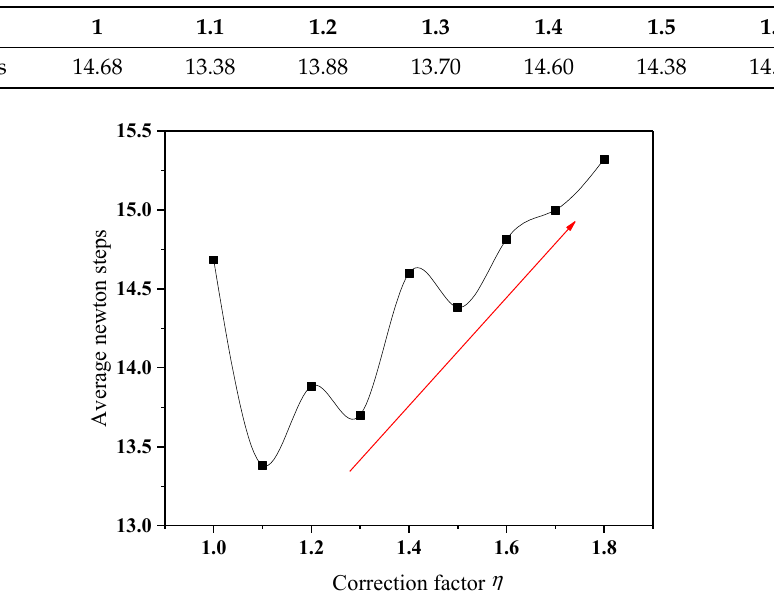
η . Figure 6. Curves of average Newton steps on correction factor η